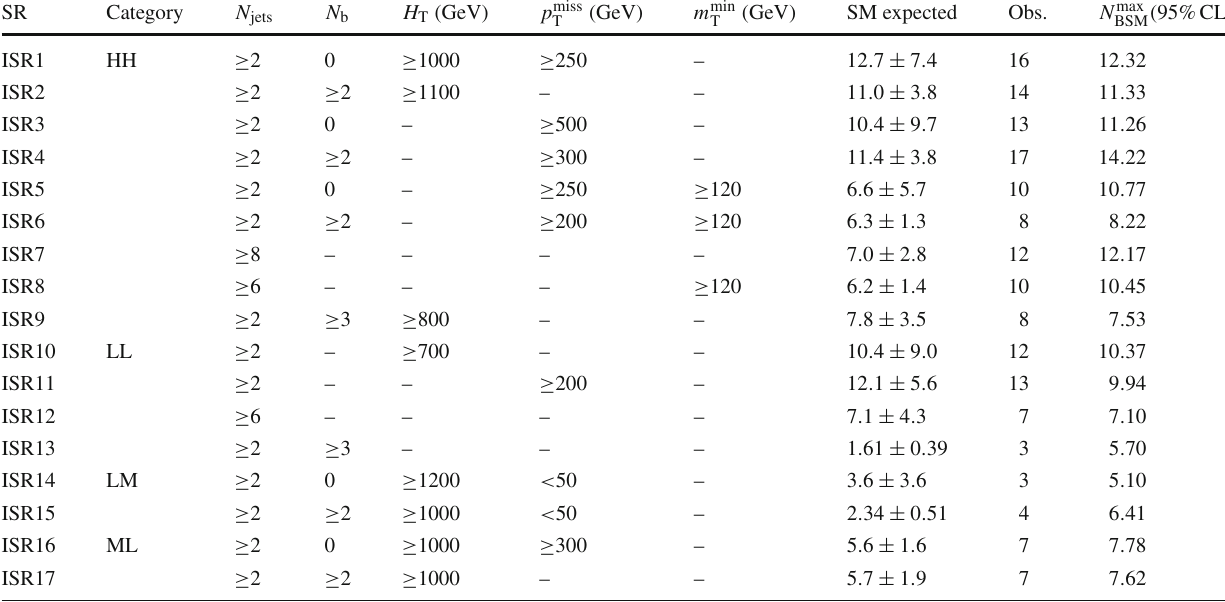
Table 10 Inclusive SR definitions, expected background yields and uncertainties, and observed yields, as well as the observed 95% CL upper limits on the number of BSM events contributing to each